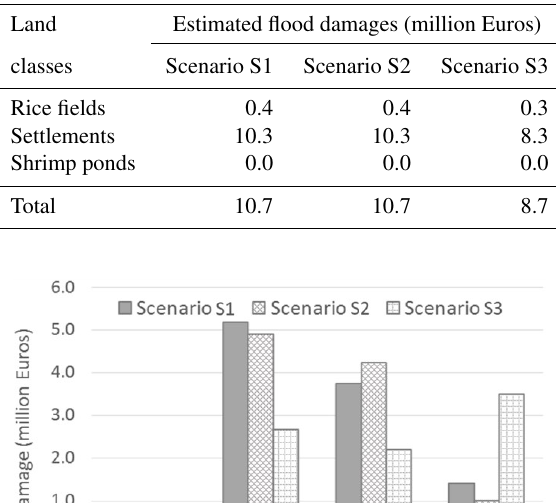
Table 4. Calculated flood damages for different land classes corre- sponding to different scenarios.